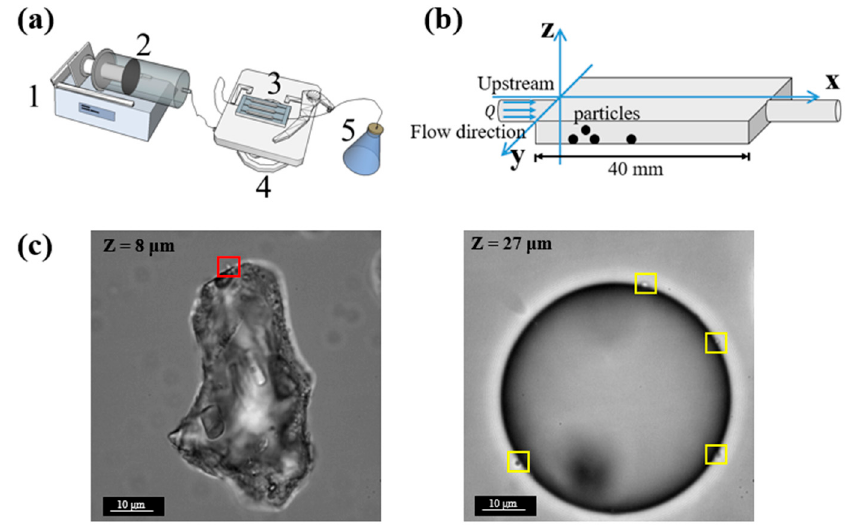
Figure 1. Schematic of a microfluidic system and a flow-cell channel. ( a ) Schematic of a microfluidic system: 1, syringe pump; 2, syringe; 3, flow cell; 4, inverted microscope; 5, waste container. ( b ) The definitions of the x-, y-, and z-axes in one channel of the flow cell: Z = 0 at the bottom of the